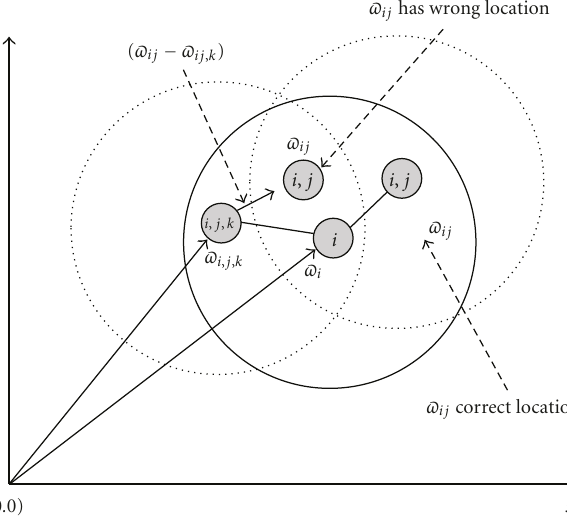
Figure 3: The case where neighboring node (cid:2) i , j is located at wrong location.